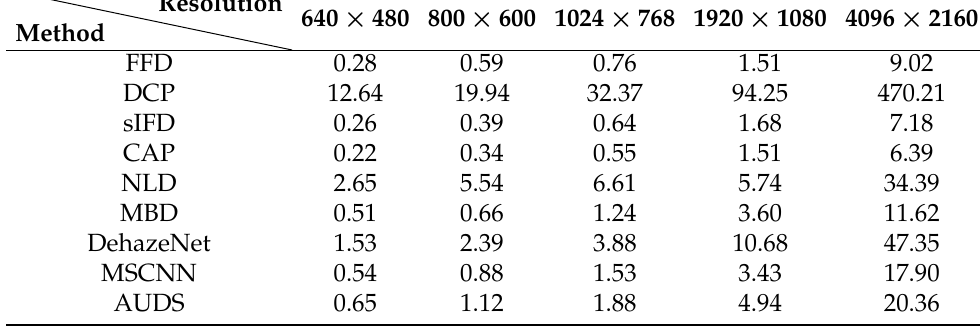
Table 5. Run-time in seconds on different image